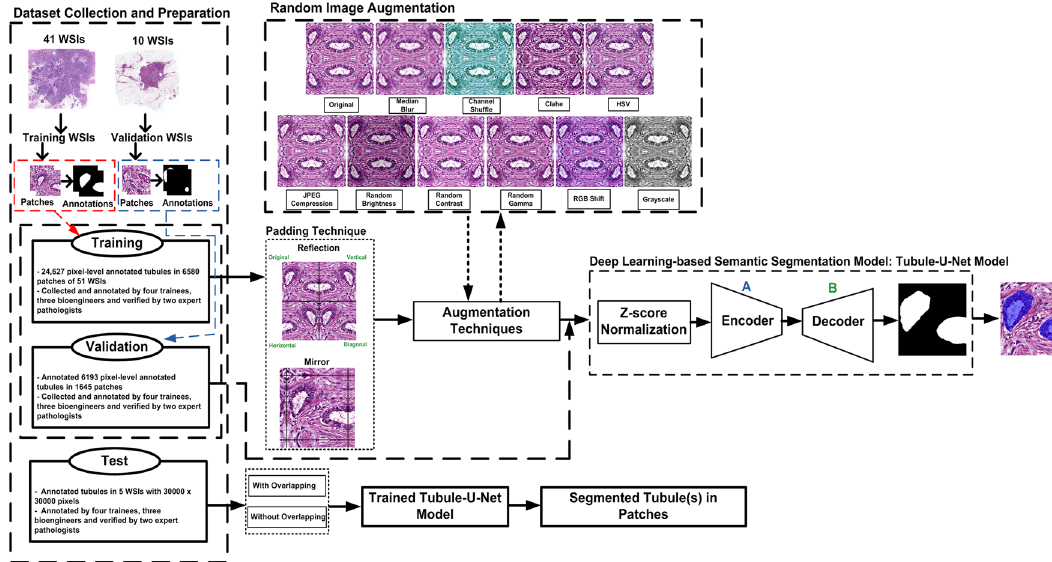
Figure 3. Flowchart of the proposed deep learning-based tubule segmentation